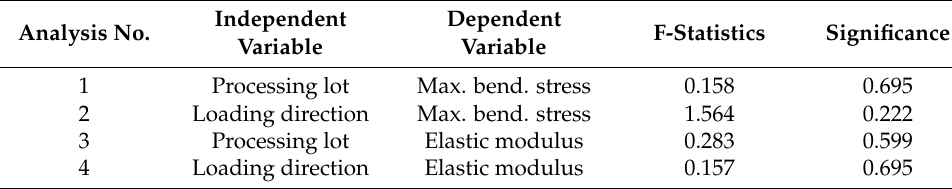
Table 4. Results of ANOVA analyses for the bending strength and the elastic modulus. Independent Dependent Analysis No. F-Statistics Significance Variable Variable 1 Processing lot Max. bend. stress 0.158 0.695 Loading direction Max. bend. stress 1.564 0.222 3 Processing lot Elastic modulus 0.283 0.599 Loading direction Elastic modulus 0.157